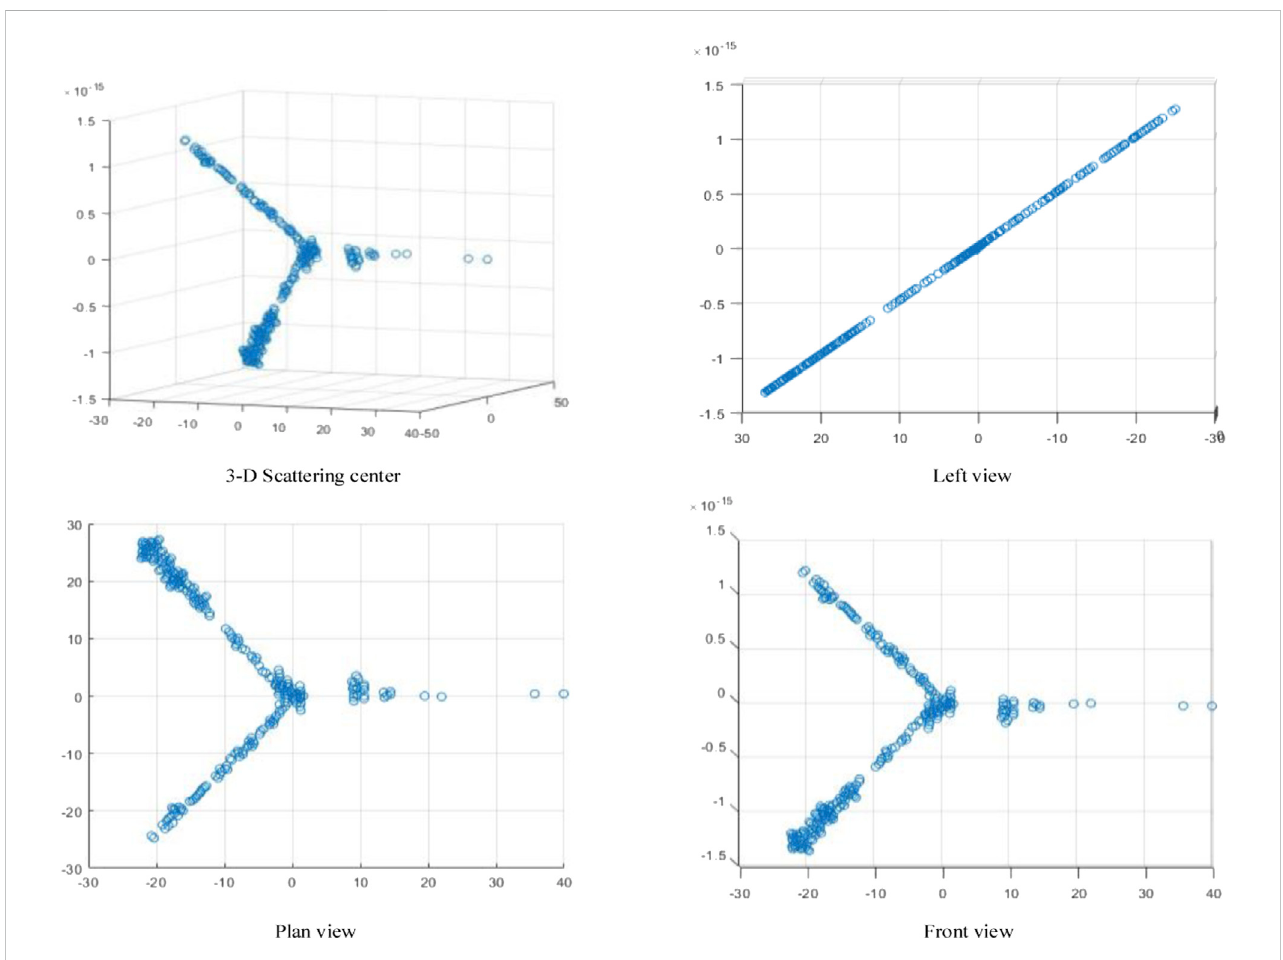
FIGURE 4 Equivalent model of the 3-D scattering center.